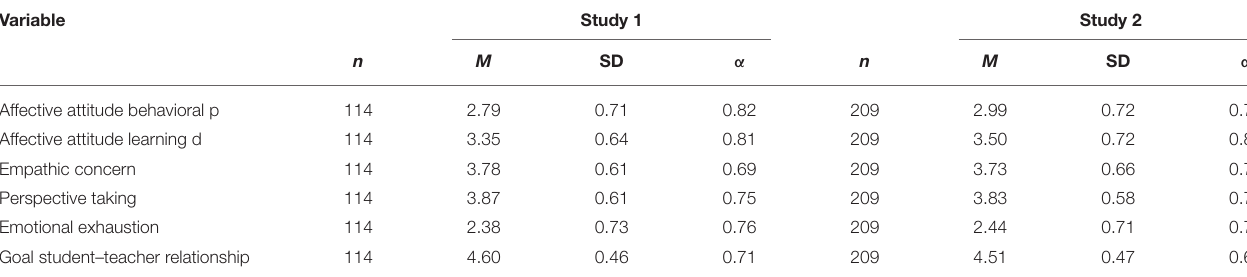
TABLE 1 | Internal consistencies for the applied scales at the first time of measurement.